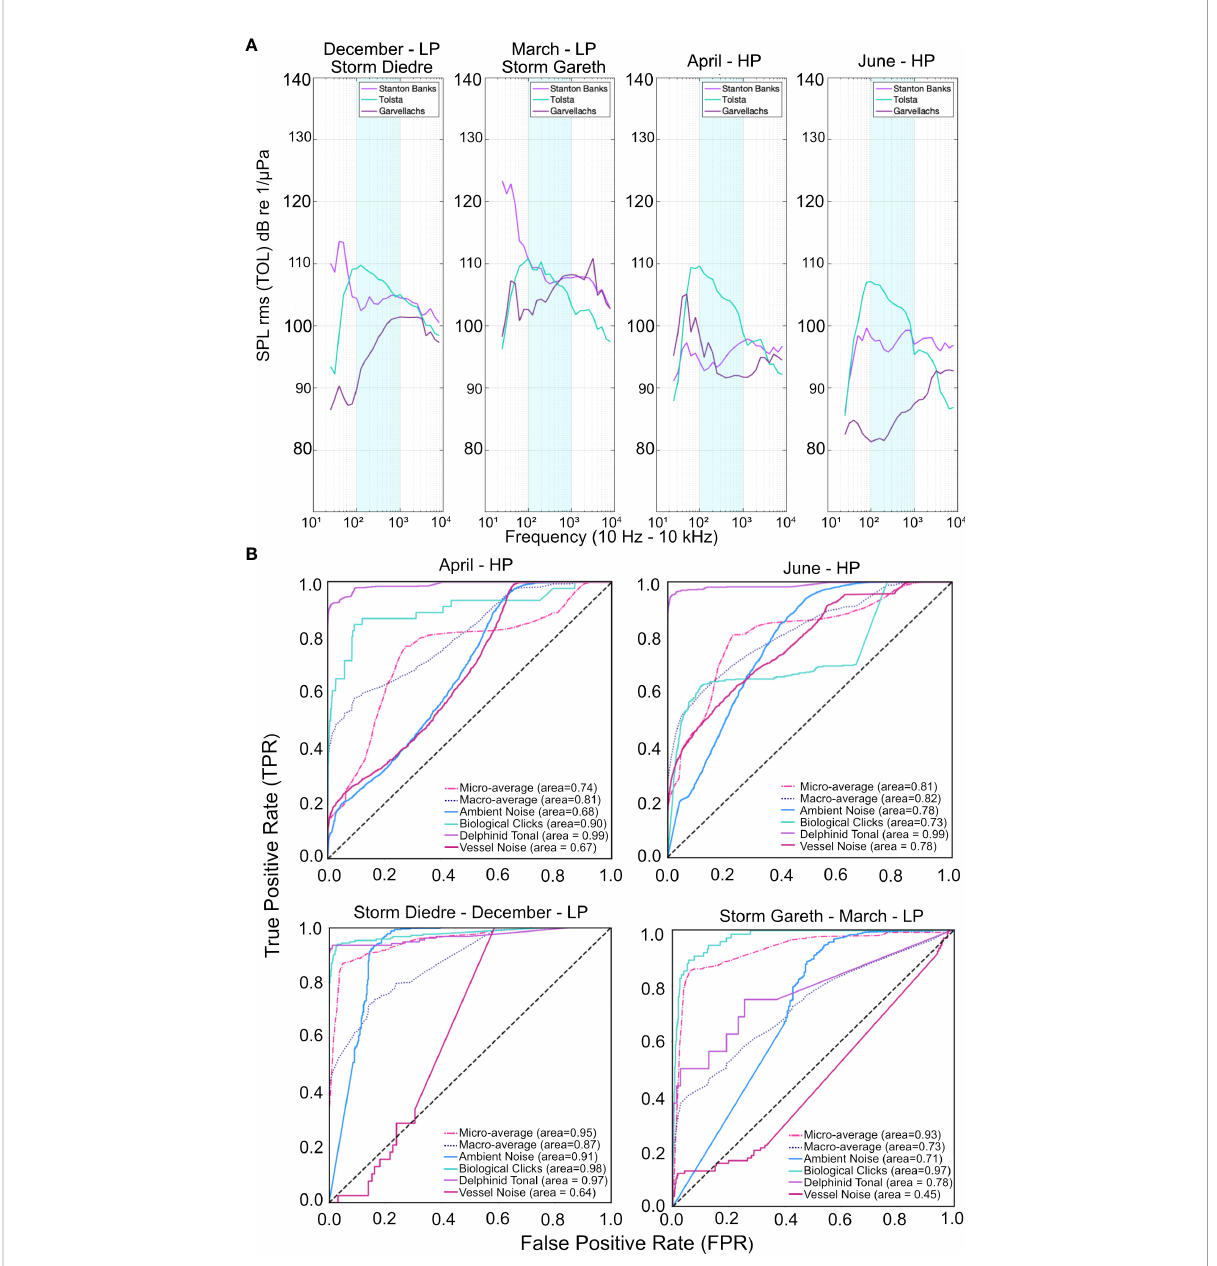
FIGURE 10 Comparison of fi delity of results of the CNN for different weather conditions which produce differing ambient noise conditions per site. (A) Median sound pressure levels for third octave bands ranging from 10 Hz to 10 kHz for Stanton Banks, Tolsta and Garvellachs within the four weather periods selected; Low Pressure (LP) systems - December (Storm Diedre) and March (Storm Gareth), and high pressure (HP) systems - April and June, demonstrating variation in soundscape characteristics per season and per site. (B) Performance metrics of the CNN are represented as ROC curves. Sound source class detection accuracy fl uctuates across seasonalities, with low-frequency geophony sounds affecting the detectability of vessel noise during storm periods (AUC = 0.64, AUC =